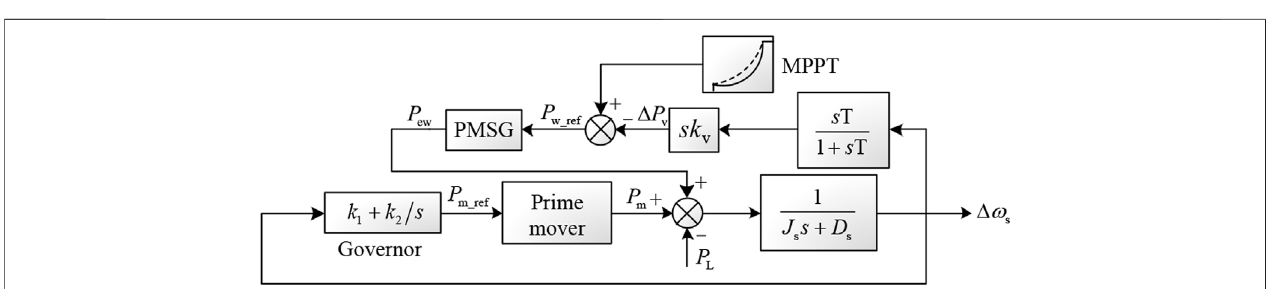
FIGURE 1 | Diagram of active power control of the system with virtual inertia.